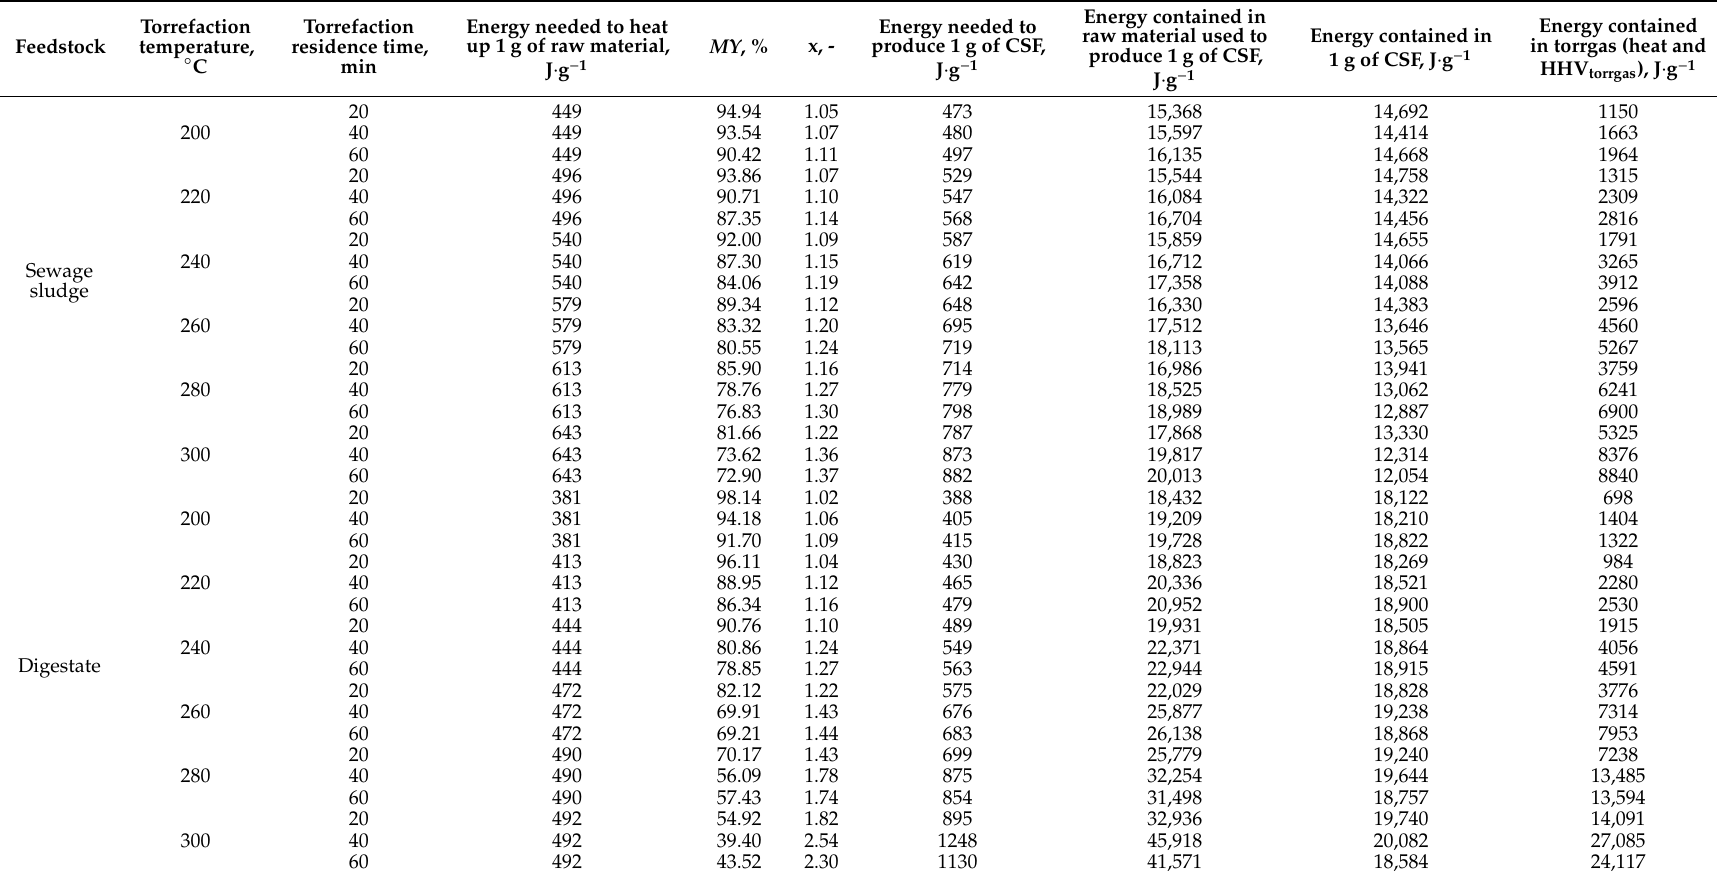
Table 2. Results of torrefaction energy